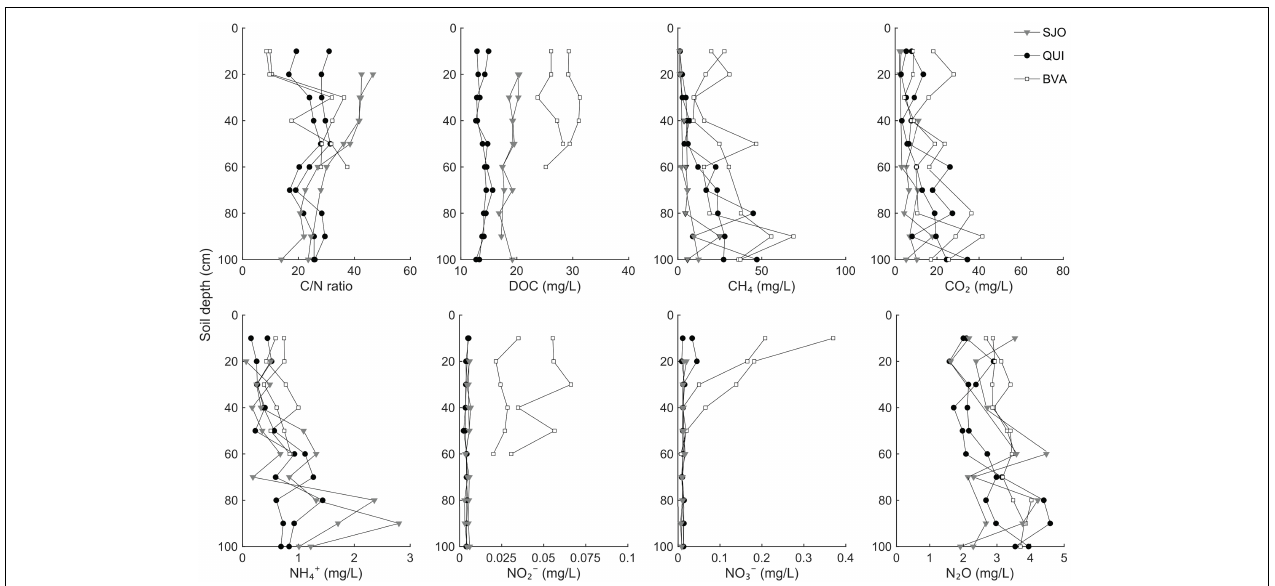
FIGURE 1 | Levels of carbon and nitrogen along soil profiles of three tropical peatlands (QUI, SJO, BVA). Two separately sampled (duplicate) profiles from Quistococha (QUI), San Jorge (SJO), and Buena Vista (BVA) were each set up to sample pore water and soil gas. Ions, total carbon and nitrogen abundances, and DOC were determined from pore water. Gas concentrations were measured in equilibrated gas samples. Liquid samples in BVA were not collected below 60 cm due to blocked sampling paths by a dense network of